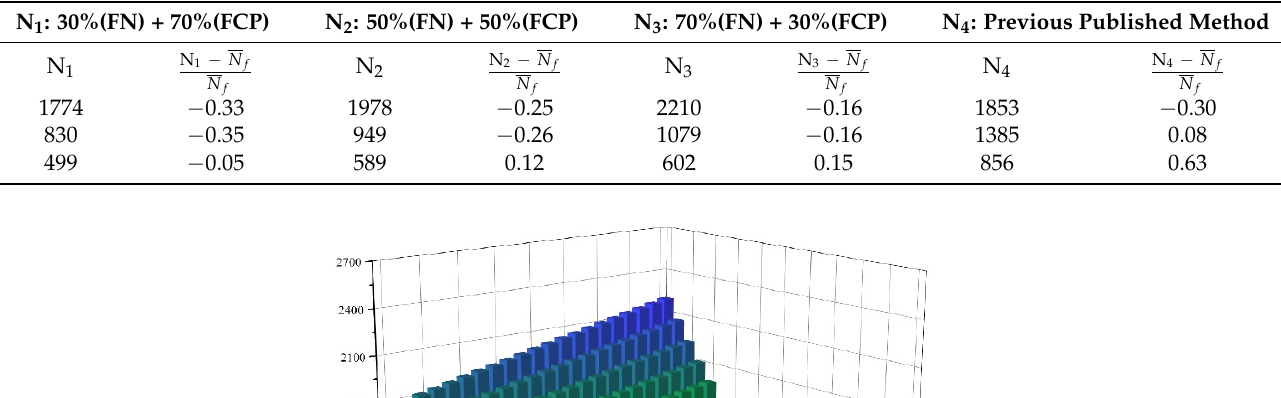
Table 6. Computation results and prediction errors made by N1, N2, N3, and N4 schemes.